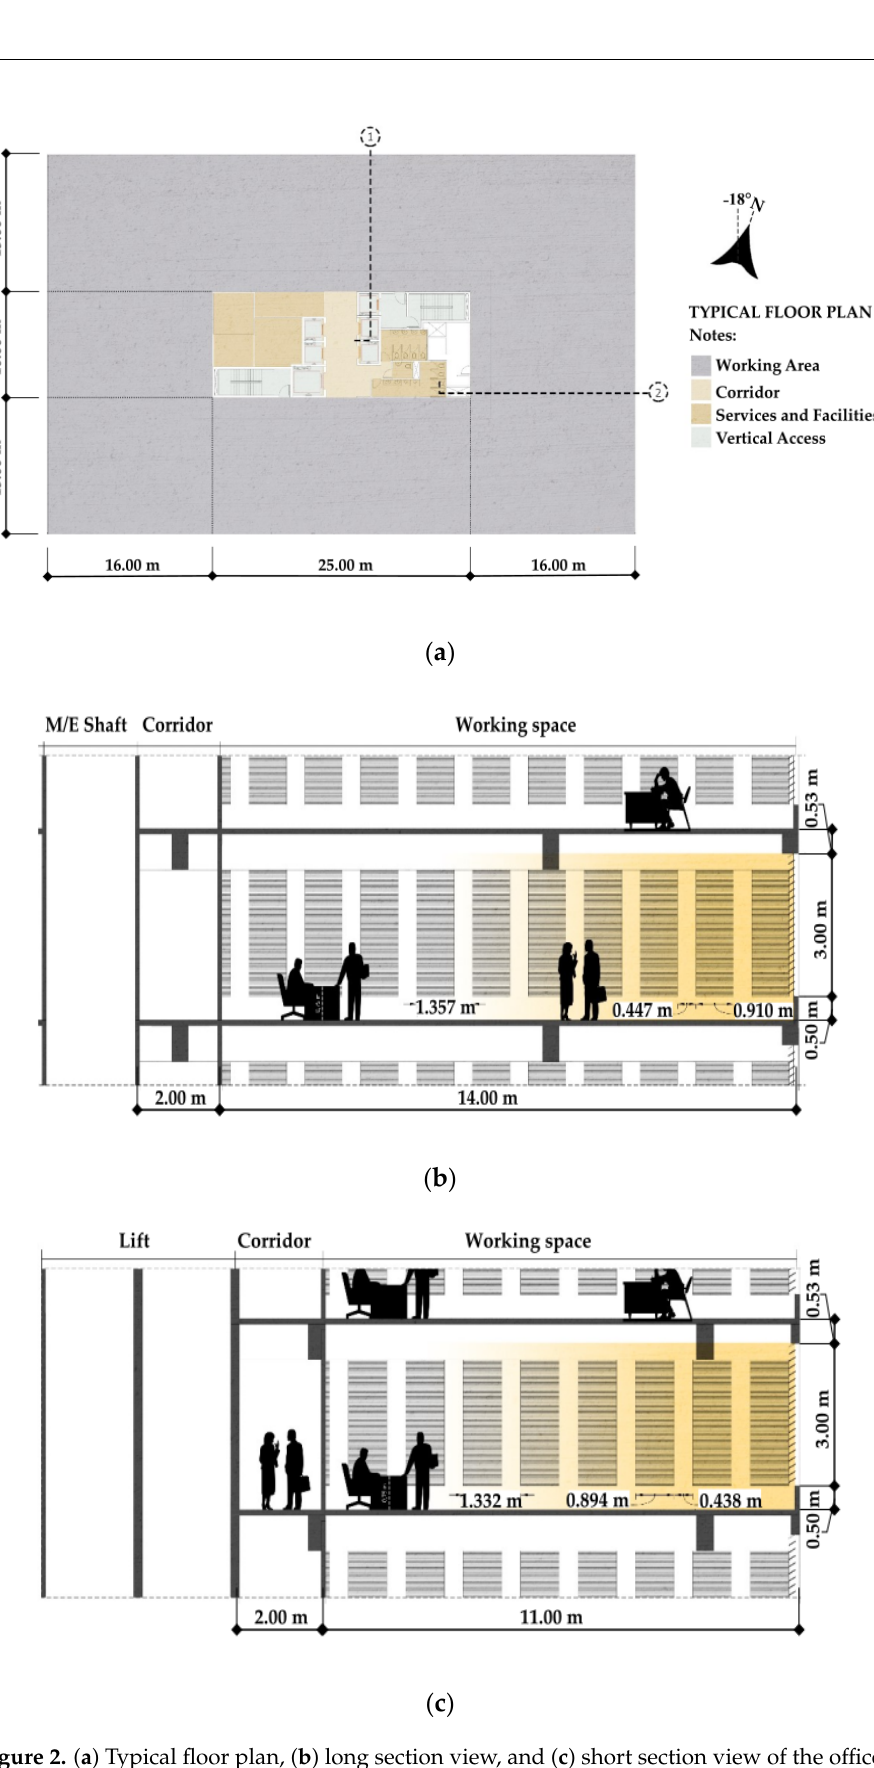
Figure 2. ( a ) Typical floor plan, ( b ) long section view, and ( c ) short section view of the office space. Three scenarios are to be considered for the modelling and simulation in this study. These are the: (1) baseline scenario: involving no shading devices; (2) fixed shading design options: involving fixed element of horizontal shading devices (venetian blinds); and (3)